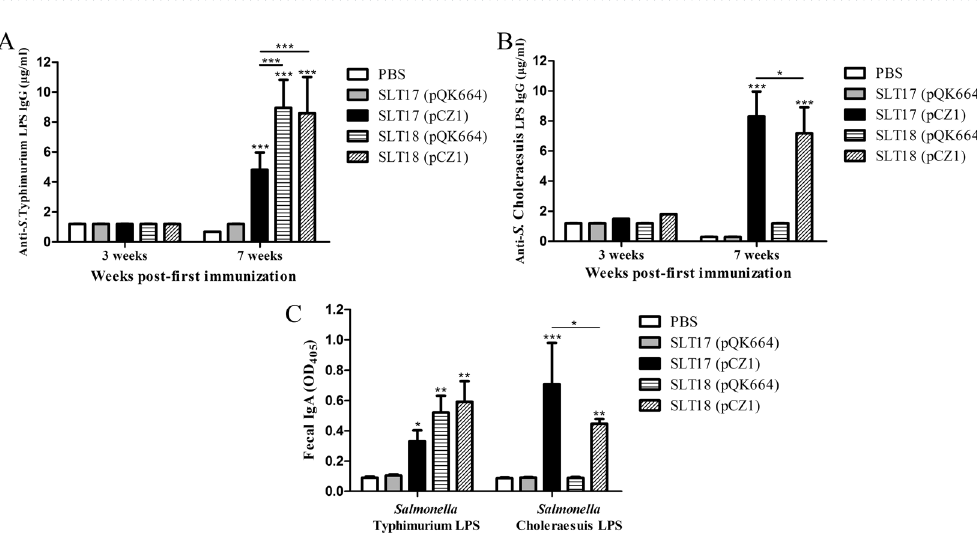
Figure 4. Antibody responses induced by the recombinant attenuated vaccines. ( A and B ) Serum IgG responses. Groups of BALB/c mice were immunized with 1 × 10 9 CFU of SLT17 (pQK664), SLT17 (pCZ1), SLT18 (pQK664), SLT18 (pCZ1) or PBS twice at an interval of 4 weeks. Serum samples were collected from 6 mice from each group 3 weeks and 7 weeks after the first immunization. The serum IgG specific to Salmonella Typhimurium LPS ( A ) and Salmonella Choleraesuis LPS ( B ) was measured by quantitative ELISA in each group ( C ). Fecal IgA responses. The fecal samples were collected from 6 mice of each group 3 weeks after the second immunization. Fecal IgAs against Salmonella Typhimurium LPS and Salmonella Choleraesuis LPS were detected by indirect ELISA. The asterisk above the error bar indicates significance compared with the PBS control group. The asterisk above the line indicates significance between the two indicated groups. * p < 0.05. ** p < 0.01. *** p <